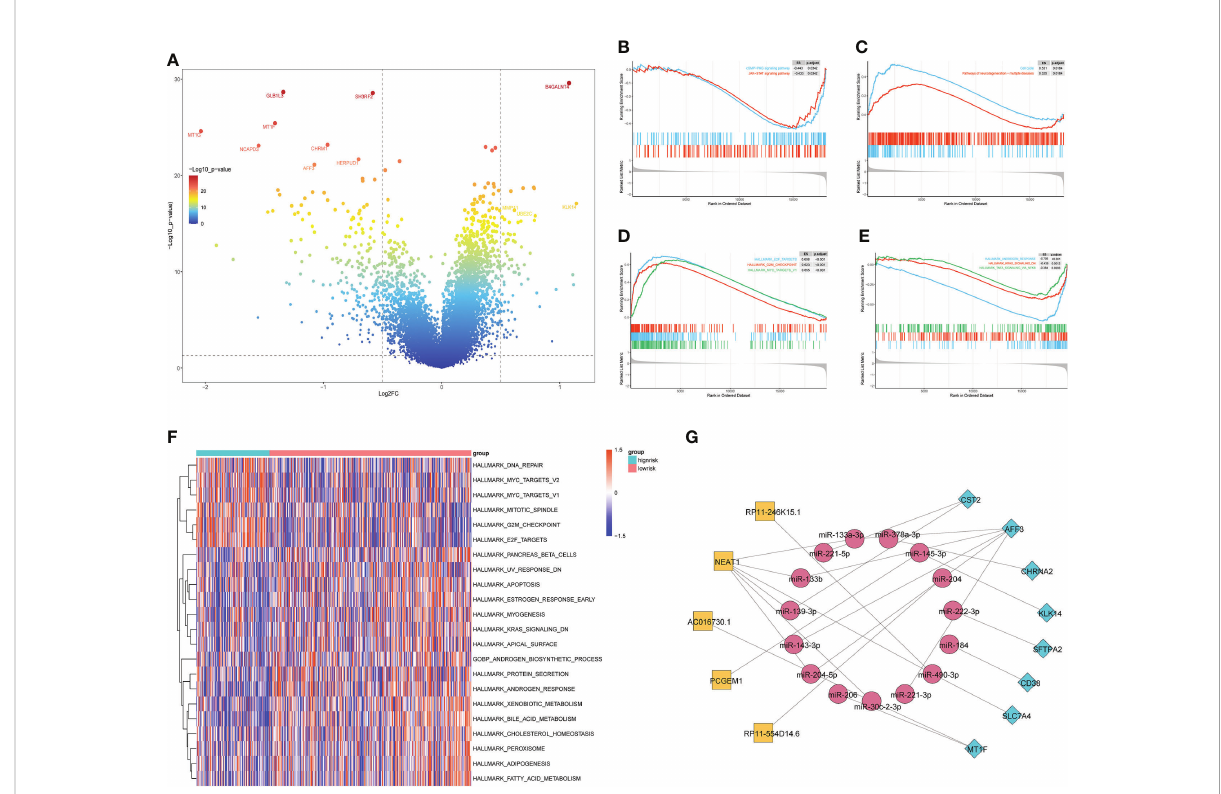
FIGURE 3 The enrichment of signaling pathways in HS and LS groups. (A) The DEGs between the HS and LS groups. (B – E) Gene Set Enrichment Analysis (GSEA) of TCGA cohort to identify signaling pathways associated with the risk model. (F) Enrichment scores of Gene Set Enrichment Analysis (GSVA) among 22 gene sets which are signi fi cant differences between the HS and LS groups. (G) Competing endogenous RNAs (ceRNA) network based on the genes in the risk